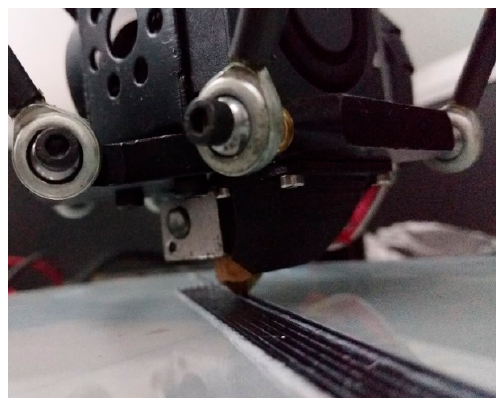
Figure 3. Continuous fiber-reinforced composite printing process.